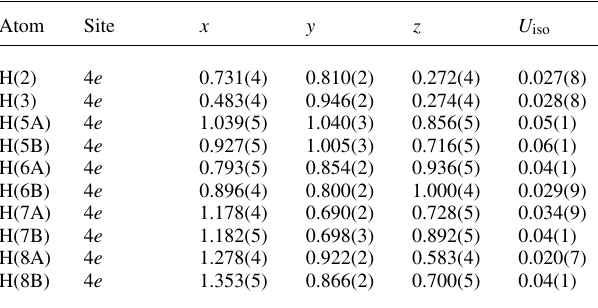
Table 2. Atomic coordinates and displacement parameters (in Å 2 )